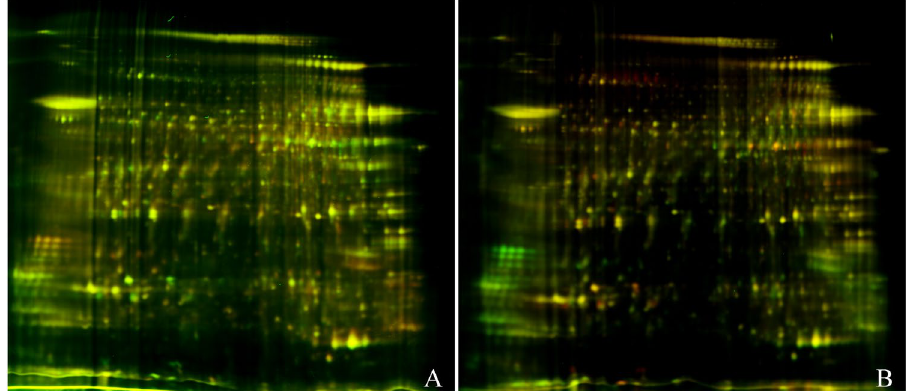
Figure 1. Representative merged 2D-DIGE gels images form sperm proteins of low- and high- fecundity group. Figure A represents the overlapped image of low- and high- fecundity group, which were labeled with cy5 and cy3 respectively; the CyDyes labels swapped in Figure B. (Cy3 = green color, Cy5 = red color, scanned by typhoon 9410).